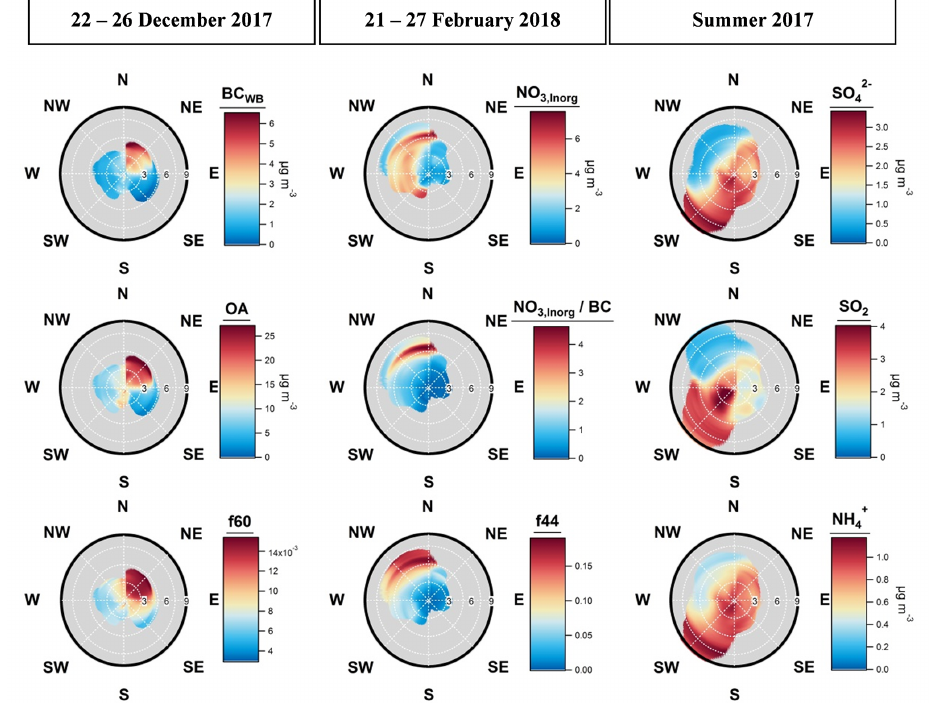
Figure 8. NWR plots for the local Christmas event, SWIM-2 plots for the long-range episode and NWR plots for the summer period. BC WB concentrations, OA concentrations and fraction of the m/z 60 ACSM organic signal are represented for the local Christmas event from 22 to 26 December 2017. NO 3 , Inorg concentrations, NO 3 , Inorg normalised by BC and fraction of the m/z 44 ACSM organic signal are displayed for the long-range influence from 21 to 27 February 2018. The SWIM-2 analysis was performed using a rolling standard deviation over 2h of wind measurements. The time periods for the events are extended to better catch the variability. SO 2 − represented for the summer of 2017. Radial and tangential axes show, respectively, the wind speed (kmh − 1 ) and the wind direction ( ◦ ).